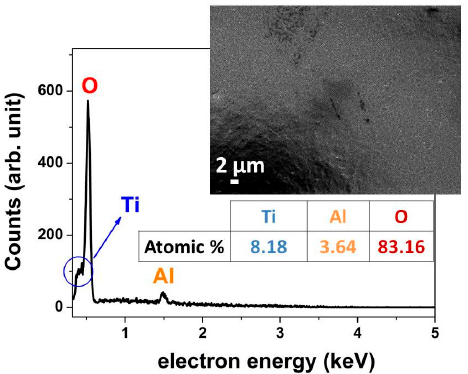
Figure 3. Energy dispersive of X-Ray spectrum of the nanoporous TiO 2 layer, synthesized in 2% H 2 O 2 solution.